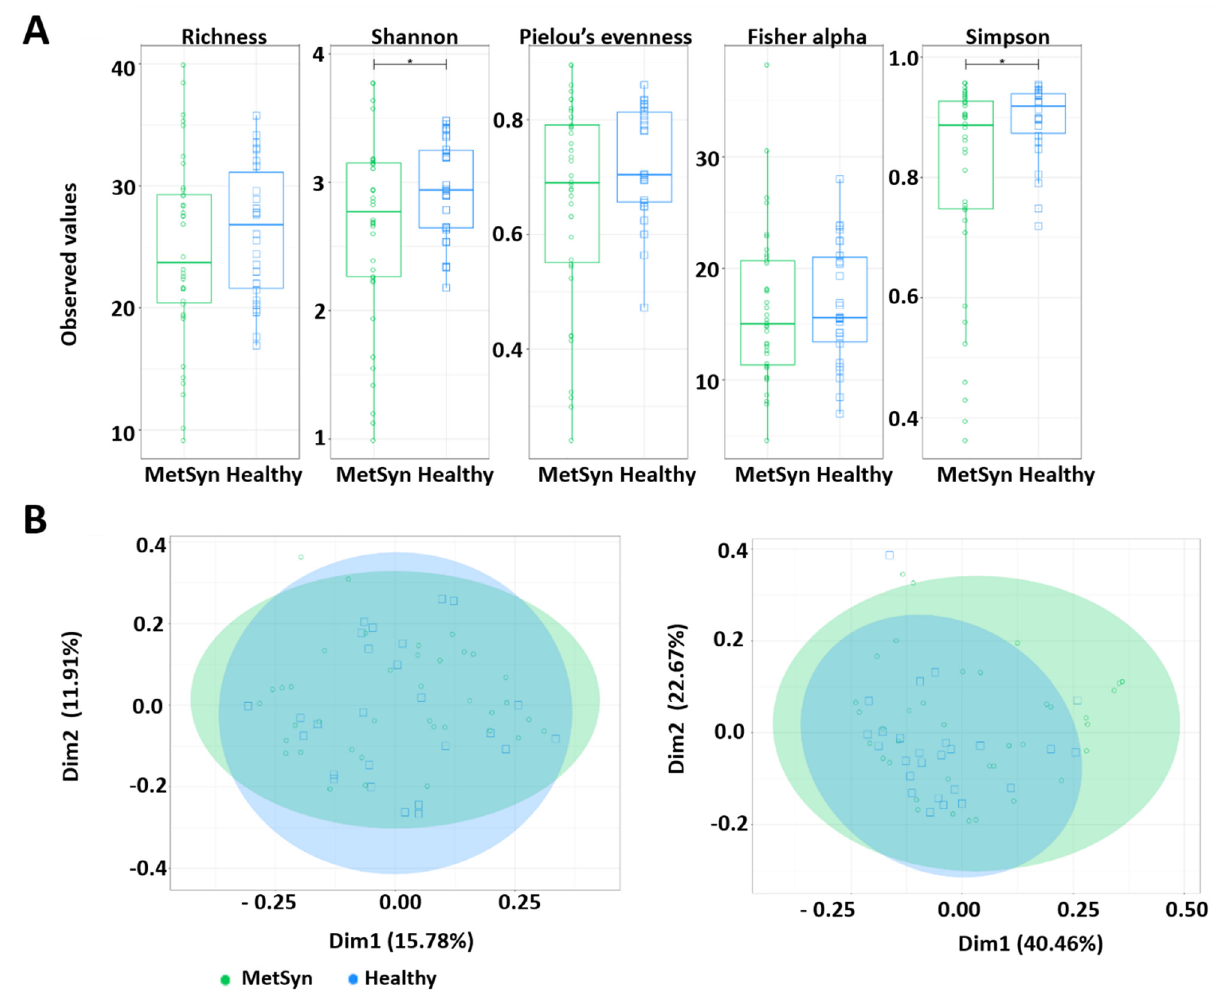
Figure 1. Microbial diversity and community structure for MetSyn vs. healthy controls. ( A ) Alpha diversity measurements between MetSyn patients and healthy controls; ( B ) Beta diversity using Bray-Curtis (left) and weighed UniFrac (right).